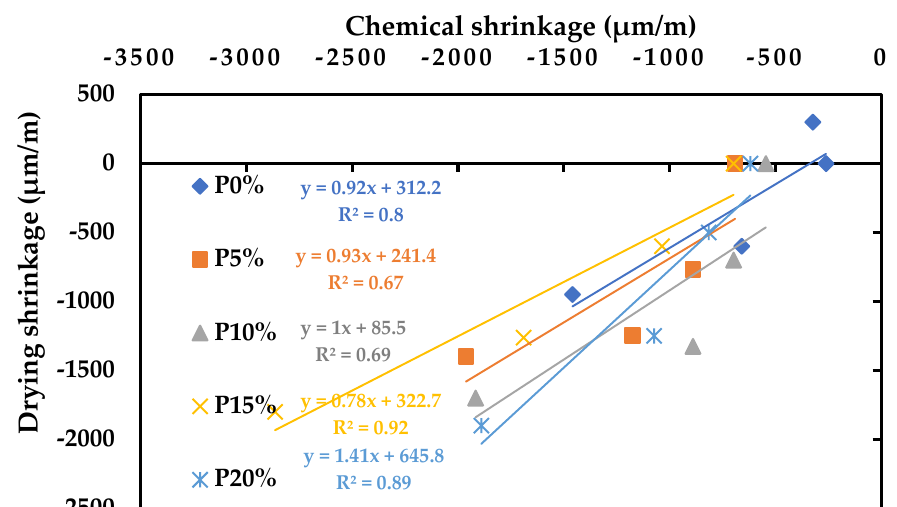
Figure 15. Correlation between chemical shrinkage and autogenous shrinkage for pastes.